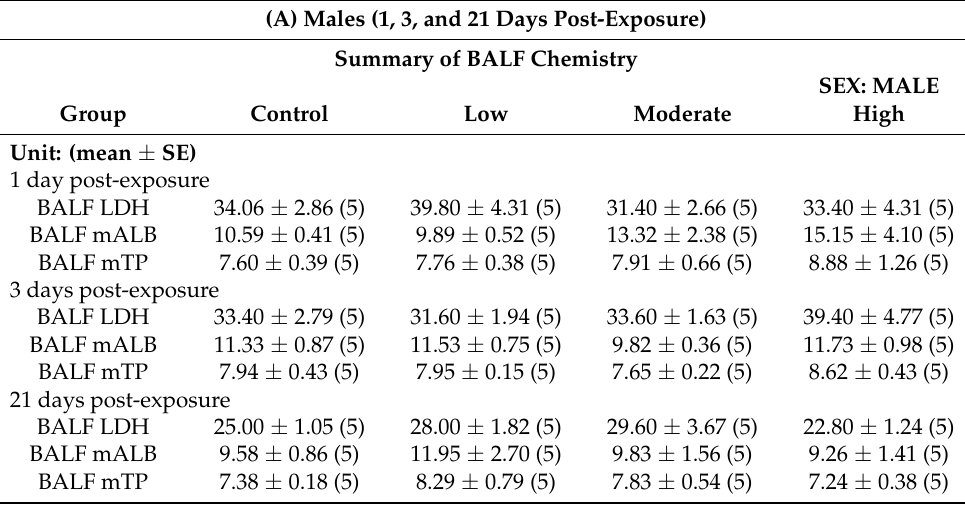
Table 4. BALF chemistry for male rats at 1, 3, and 21 days after CNF exposure.